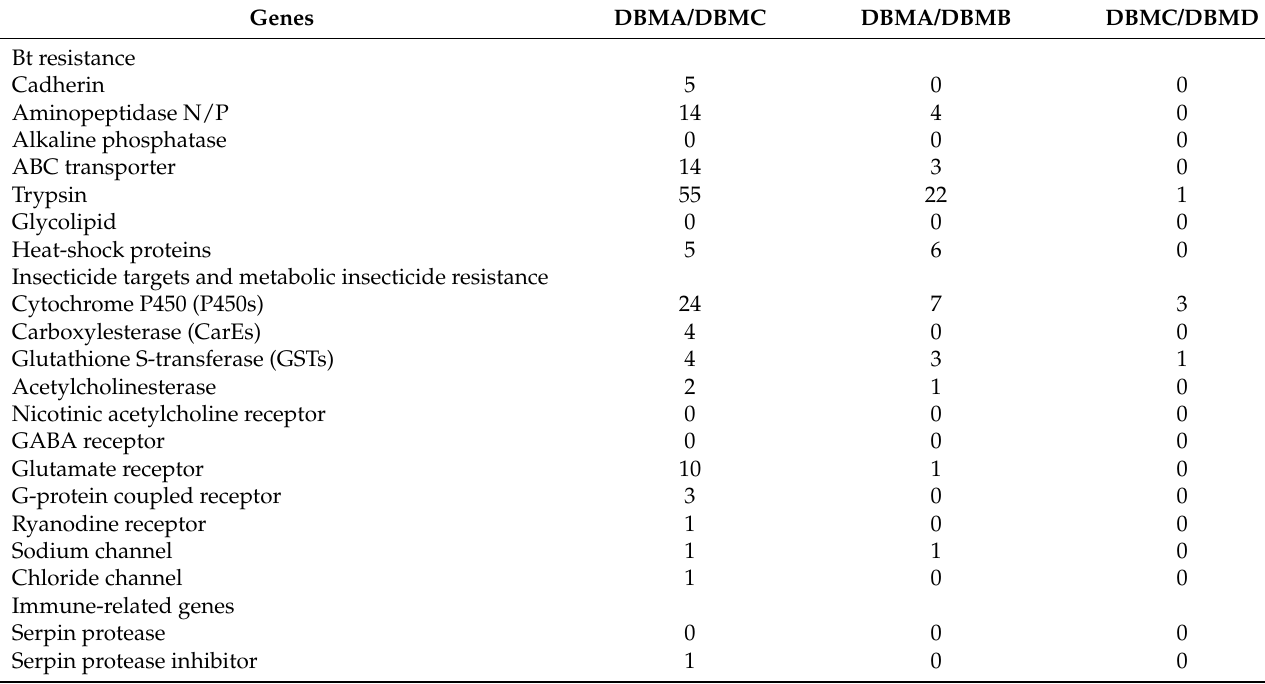
Figure 4. The number of differentially expressed genes with different values of log 2 fold-change between susceptible (G88, DBMA) and resistant (Cry1S1000, DBMC) strains. Table 3. The number of differentially expressed genes potentially participated in Cry1Ac resistance in P. xylostella . DBMA, DBMB, DBMC, and DBMD represent the strains of G88, G88 with toxin treatment, Cry1S1000, and Cry1S1000 with toxin